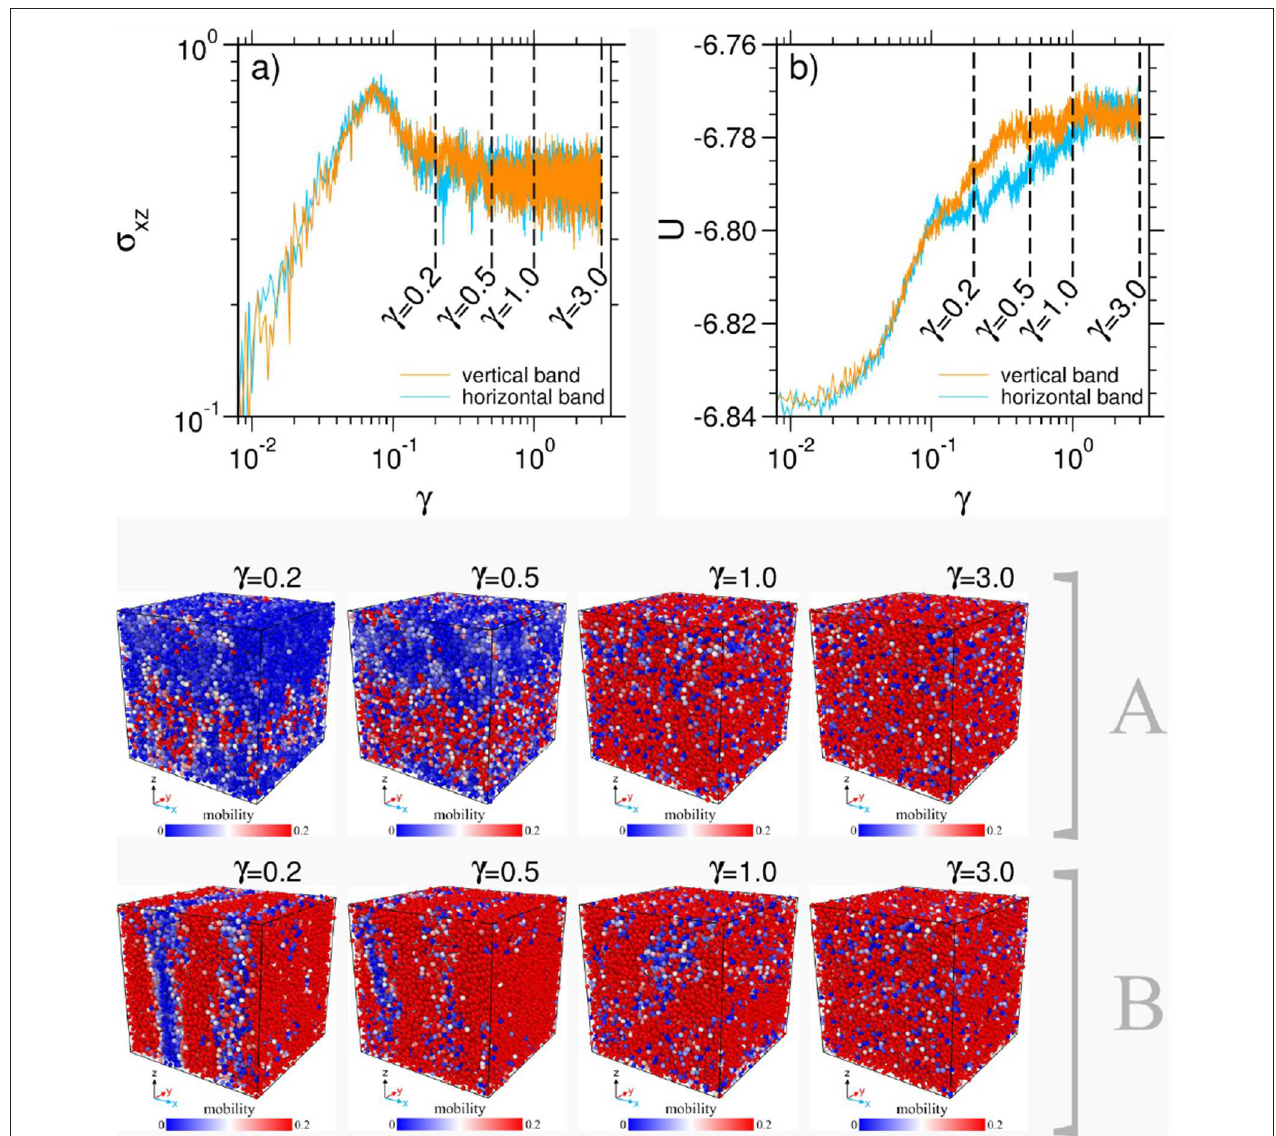
FIGURE 4 | (a) Stress-strain relation, σ xy ( γ ), for individual samples with vertical shear bands (orange curve) and horizontal shear band (cyan curve) at the shear rate γ 10 − 4 and the temperature T 0.2. (b) Potential energy as a function of strain, U ( γ ), for the same samples as in (a) . The vertical dashed lines in (a,b) mark the ˙ = = strain values at which the mobility maps are shown in the lower panels for the case with horizontal shear band (A) and vertical shear bands